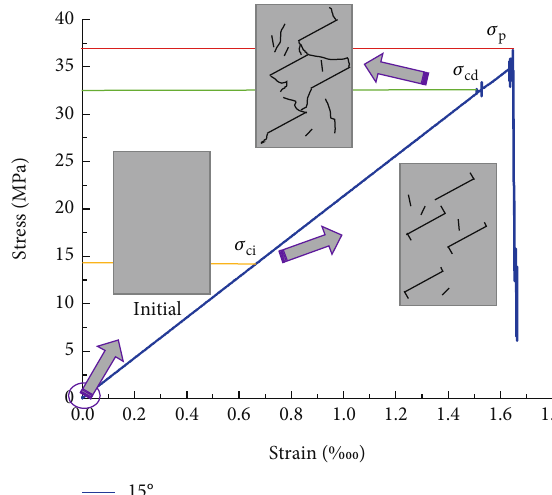
Figure 7: Division of stress-strain curve and evolution stage of microcracks in rocks with 15 ° inclination angle.